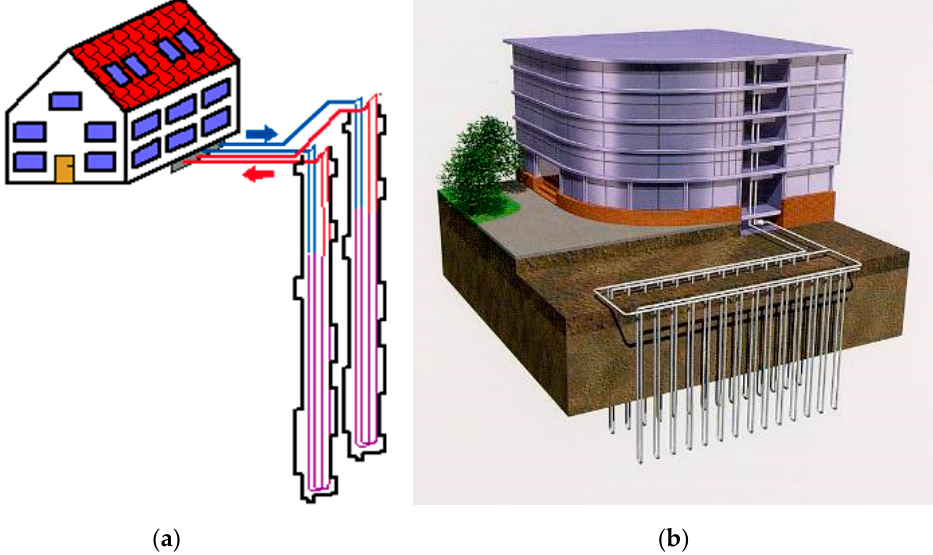
Figure 2. Installation diagram with ground source heat pumps (GSHPs) and BHEs, ( a ) two BHEs with double supply U-tubes, connected to the evaporator or GSHP condenser inside the building, ( b ) visualization of a building with GSHP and BHEs [13].